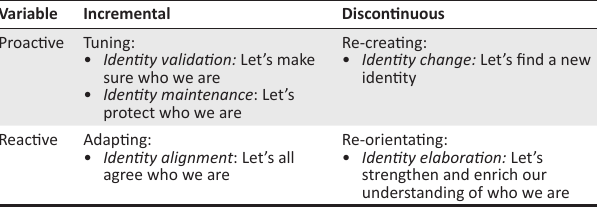
TABLE 2: Typology of identity-change needs. Variable